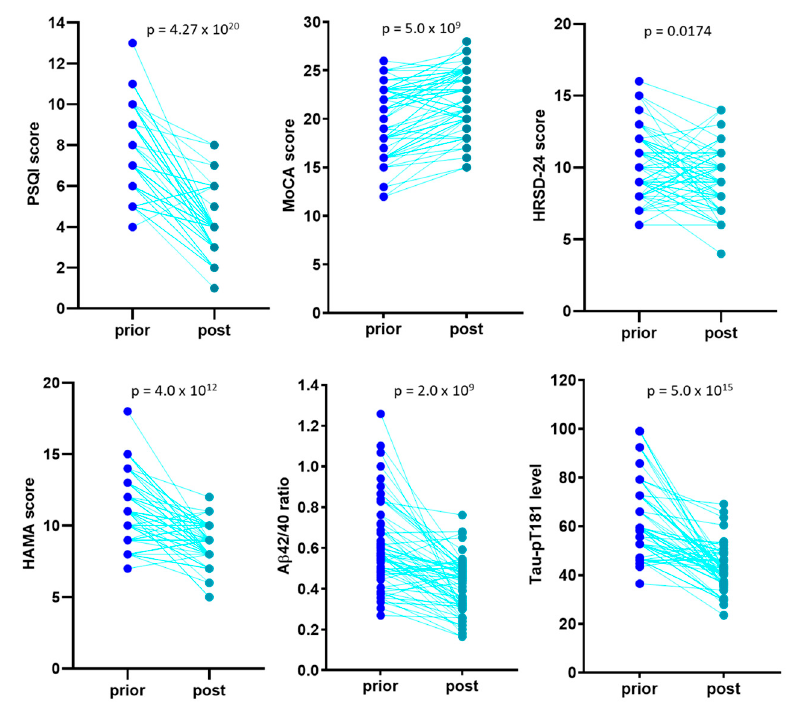
Figure 3. Sleep treatment improves neuropsychological scores, blood A β 42/40 ratio, and Tau-pT181 protein level. Data were presented as case-controlled pairs of prior- and post-treatment values. The p values were derived from a pair-wise t -test.